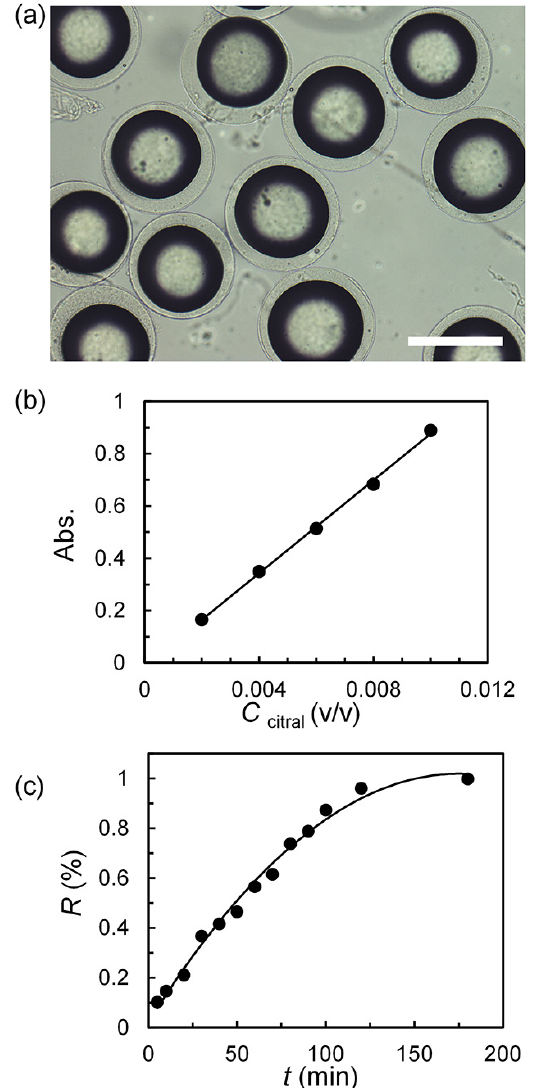
Figure 8. Sustained releasing properties of citral-containing alginate microcapsules. ( a ) Optical micrographs of citral-containing alginate microcapsules. The standard curve ( b ) and the release kinetics of citral from the alginate microcapsules ( c ). Scale bars are 200 µ